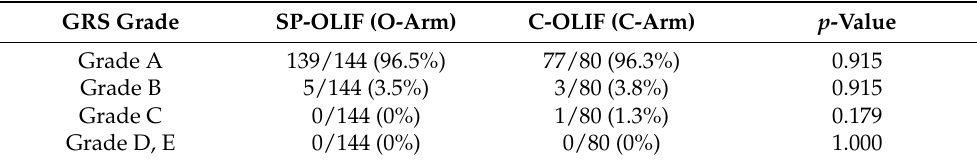
Table 3. Lumbar pedicle screw placement accuracy grades according to the Gertzbein-Robbins classification